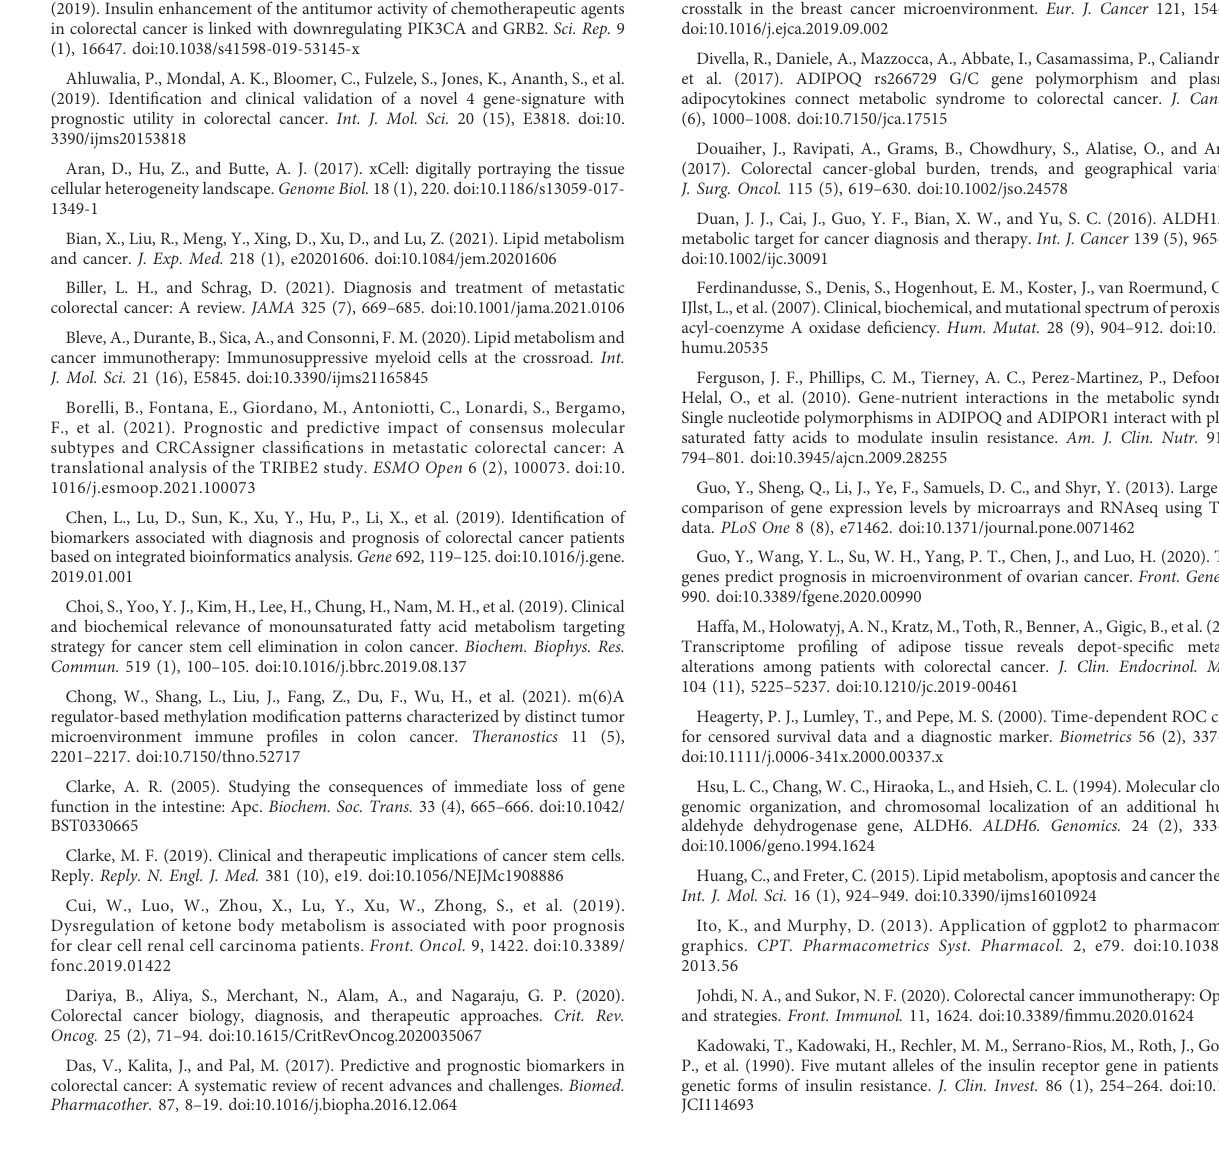
SUPPLEMENTARY FIGURE S1 Technical details of consensus molecular subtypes analysis. (A) consensus index. (B) K = 2 was regarded as the optimal value in consensus molecular subtypes of colorectal cancer. CDF: Cumulative Distribution Function. SUPPLEMENTARY FIGURE S2 The association between risk score and clinical features, including age, (A) gender (B) ,andrace (C) . “ ≤ 60 ” :Patientslessthanorequalto 60 years of age; “ > 60 ” : Patients over 60 years of